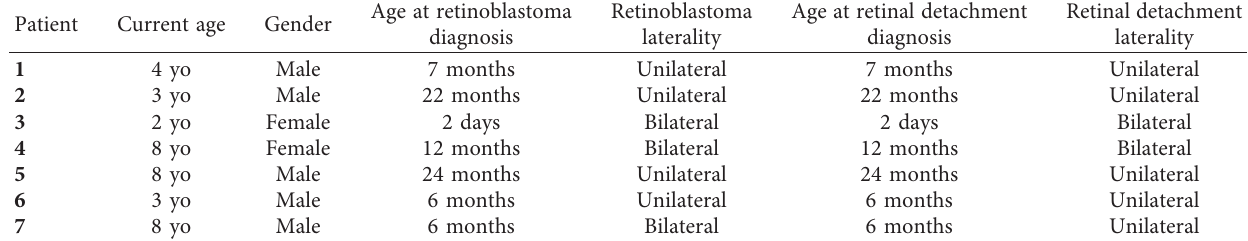
Table 1: Age of retinoblastoma and retinal detachment diagnosis.